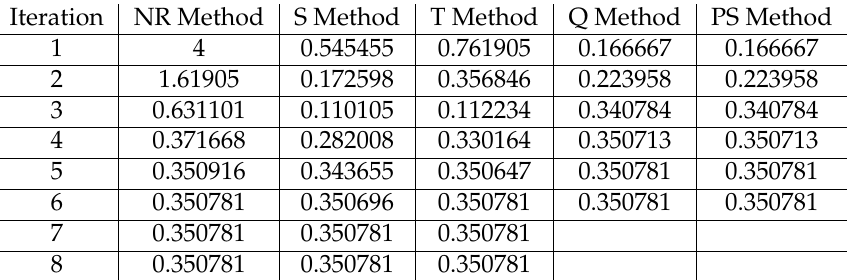
Table 3. Numerical results for the Equation